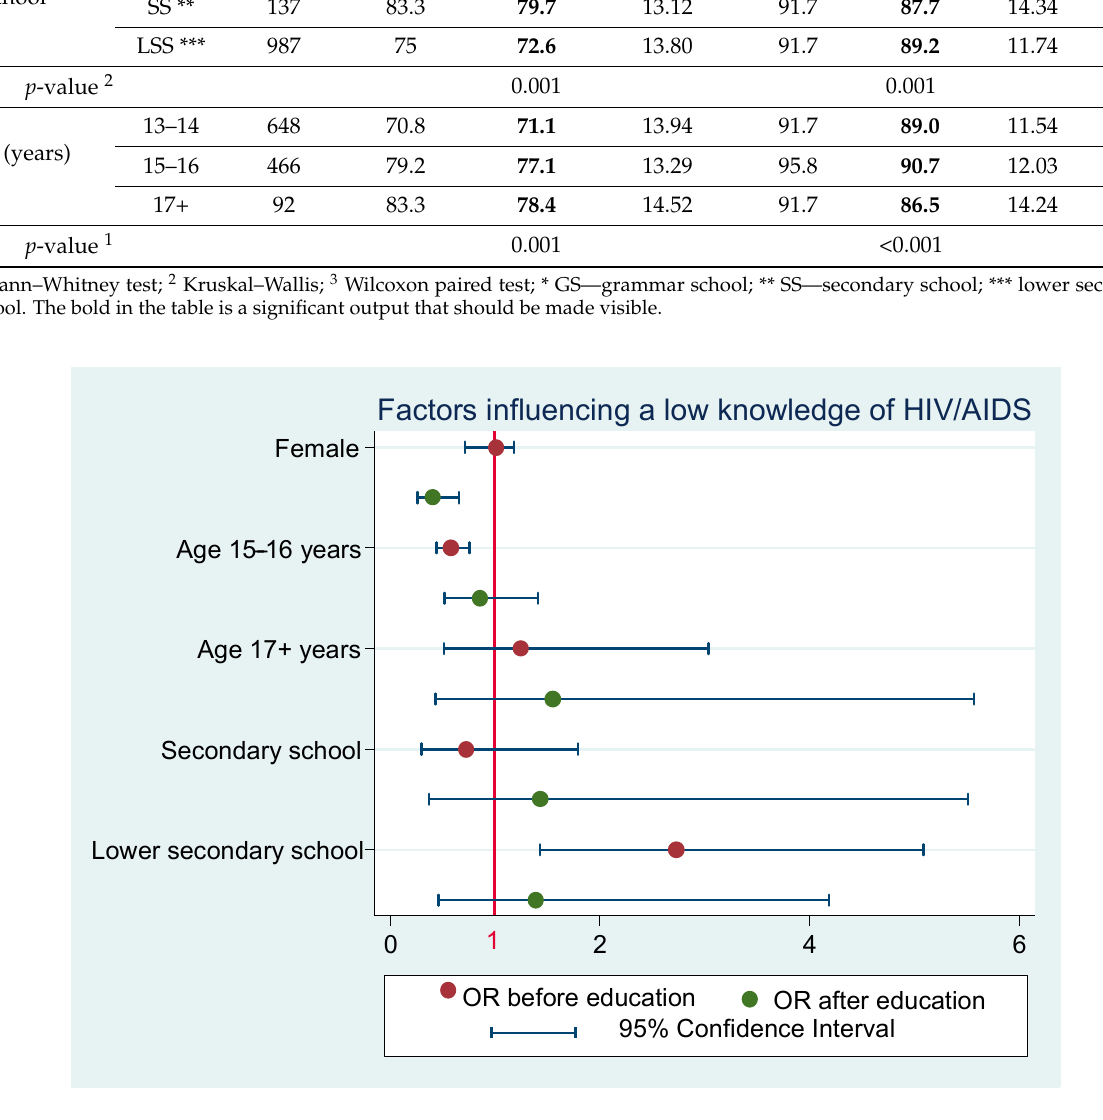
Figure 1. Results of models monitoring the influence of gender, age, and type of schools on the low knowledge of HIV/AIDS (1: Total % score < 70). OR—odds ratio; baseline—male, age 13–14 years, grammar school. Model (before education) fully adjusted: p = 0.025; model (after education) fully adjusted: p < 0.001 .